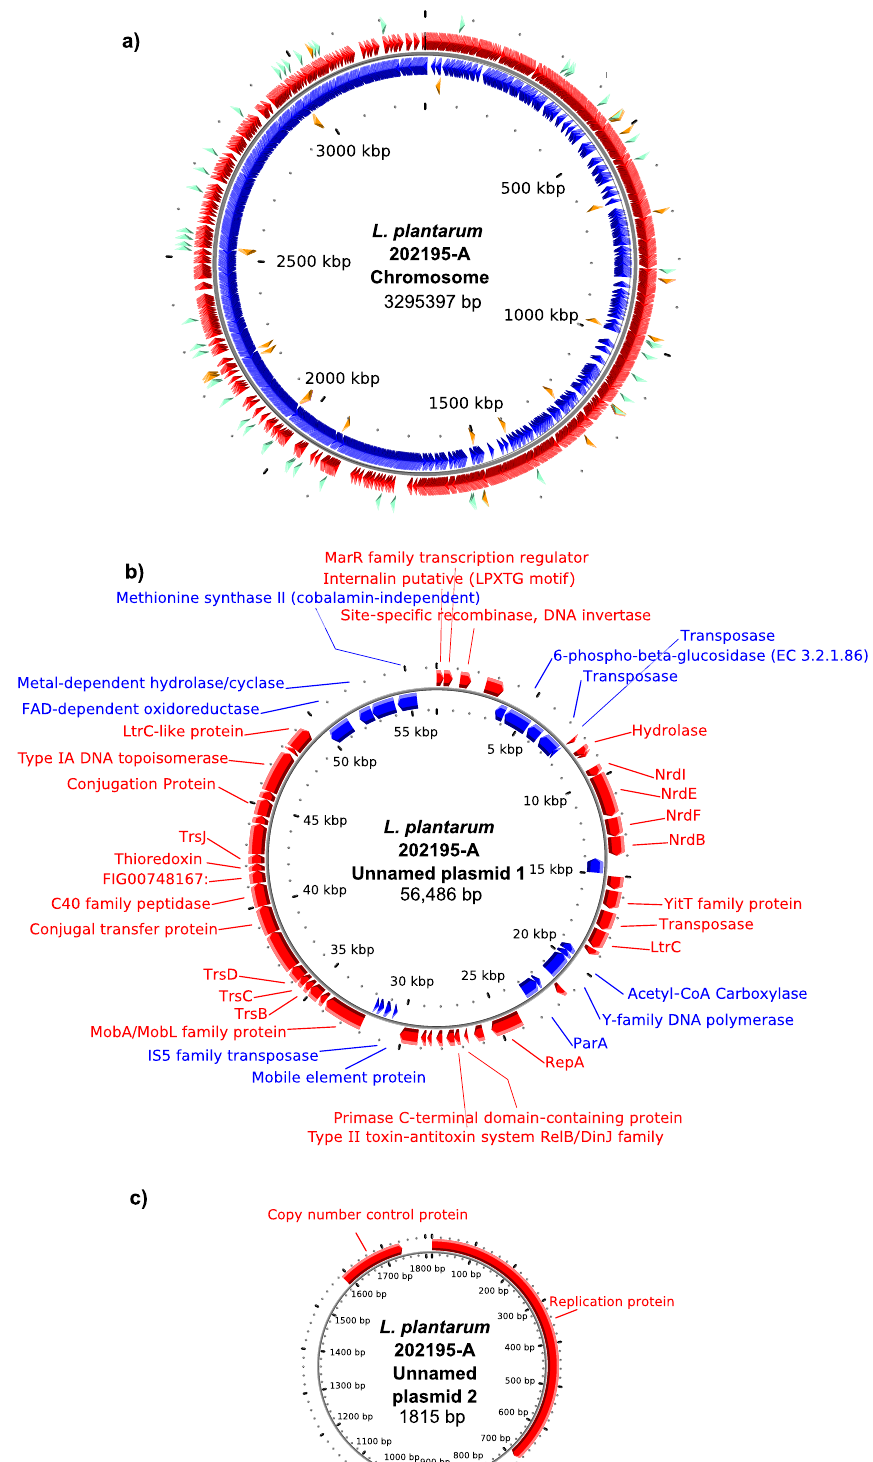
Figure 1. Circular genomic map of the L. plantarum ATCC 2021295-A. ( a ) The chromosome is 3,295,397 base pairs in size and has a G + C content of 44%. ( b ) Unnamed plasmid 1 (56,486 base pairs, G + C content = 40%); and, ( c ) Unnamed plasmid 2 (1815 base pairs, G + C content = 37.4%). Images were generated using CGViewer 24 and gene annotation was prepared using RASTtk 25 . Forward strand genes are denoted as red arrows, reverse strand genes are denoted as blue arrows, RNA genes are denoted as orange arrows, and repeat regions are denoted as aqua coloured arrows. The original image was generated using GC Viewer (https:// pauls totha rd. github. io/ cgview/) and the text was modified in Inkscape v1.0.1 (https:// inksc ape. org/ relea se/ inksc ape-1.